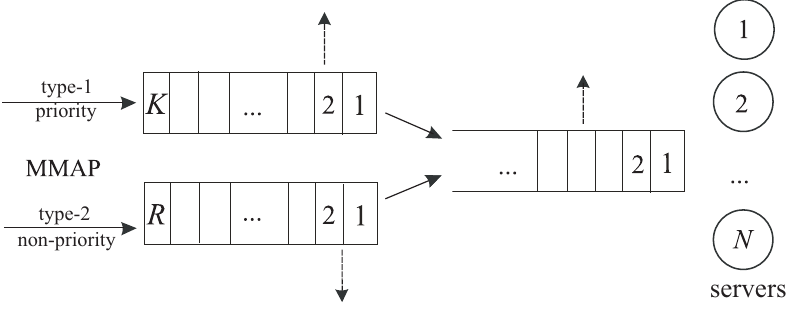
Figure 1. Structure of the